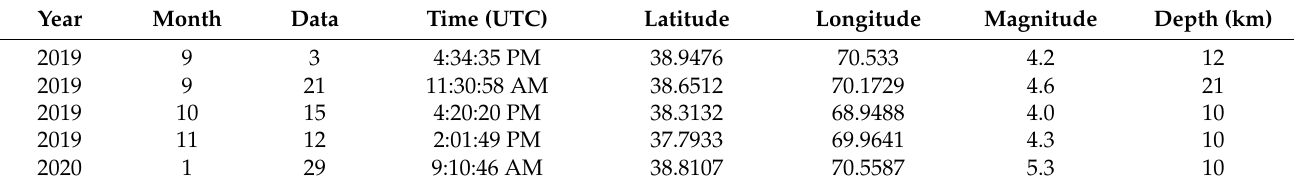
Table 5. List of the five earthquakes used for the standard spectral ratio (SSR) calculations. Epicenters had a maximum distance of 150 km to